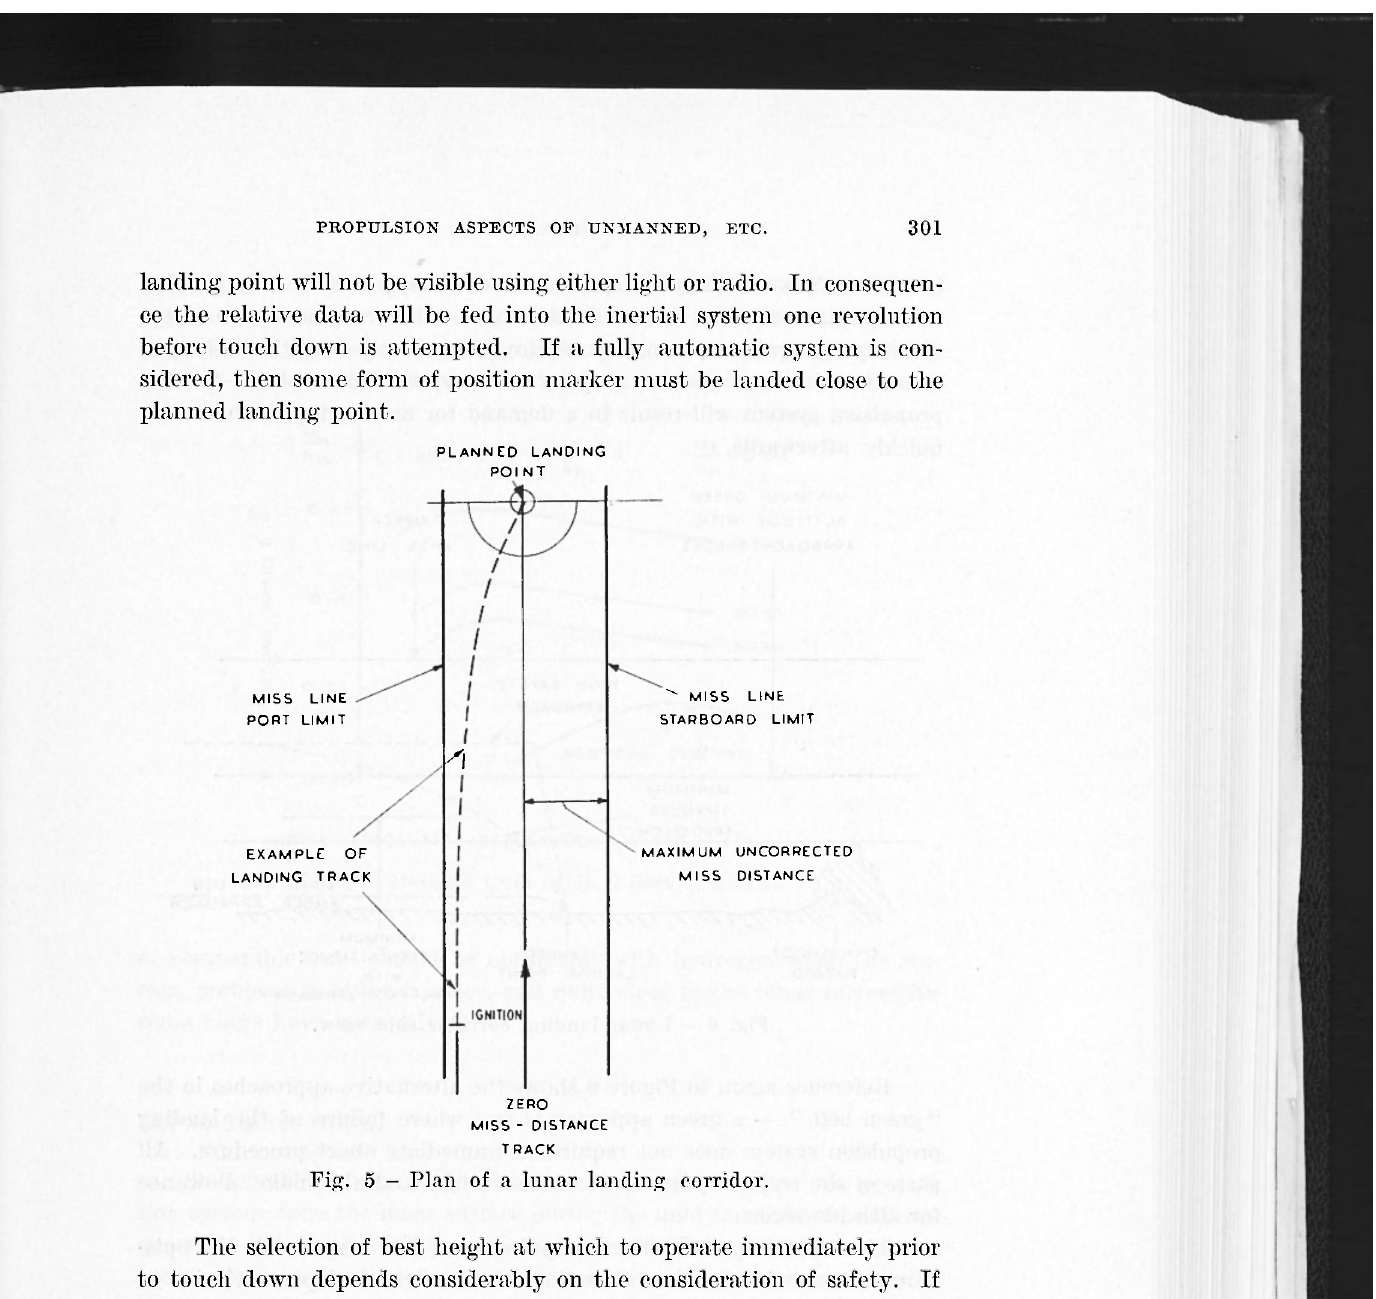
Fig. 5 - Pian of a lunar landing